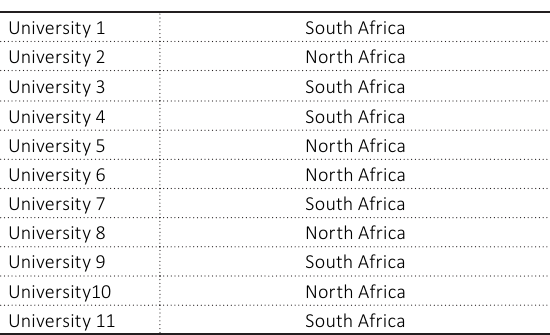
Table 5. University respondents by number and